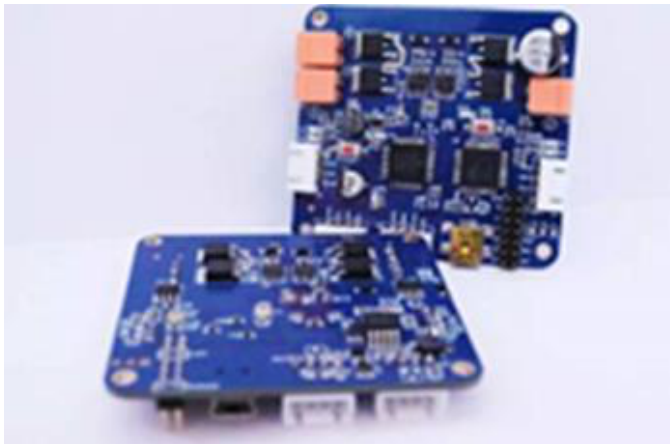
Figure 16. Motor driver.